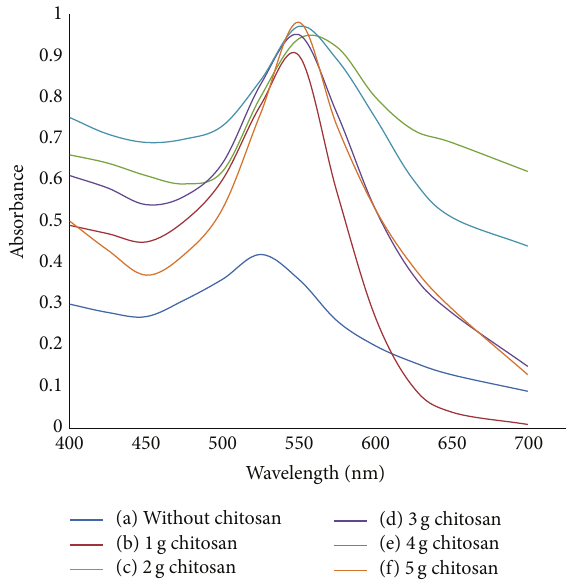
Figure 7: Absorption spectra of bare and increased weight of chitosan capped AuNPs at the optimum concentration of reducing agent MSG: (a) 0 g chitosan; (b) 1g chitosan; (c) 2 g chitosan; (d) 3 g chitosan; (e) 4 g chitosan; (f) 5g